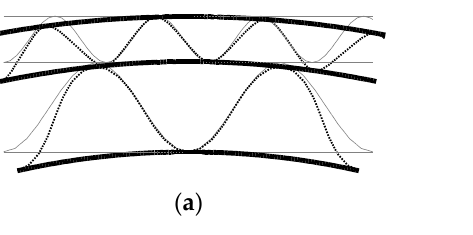
Figure 9. Numerical model of corrugated board: ( a ) 2-period FE model ( b ) 4-period FE model.